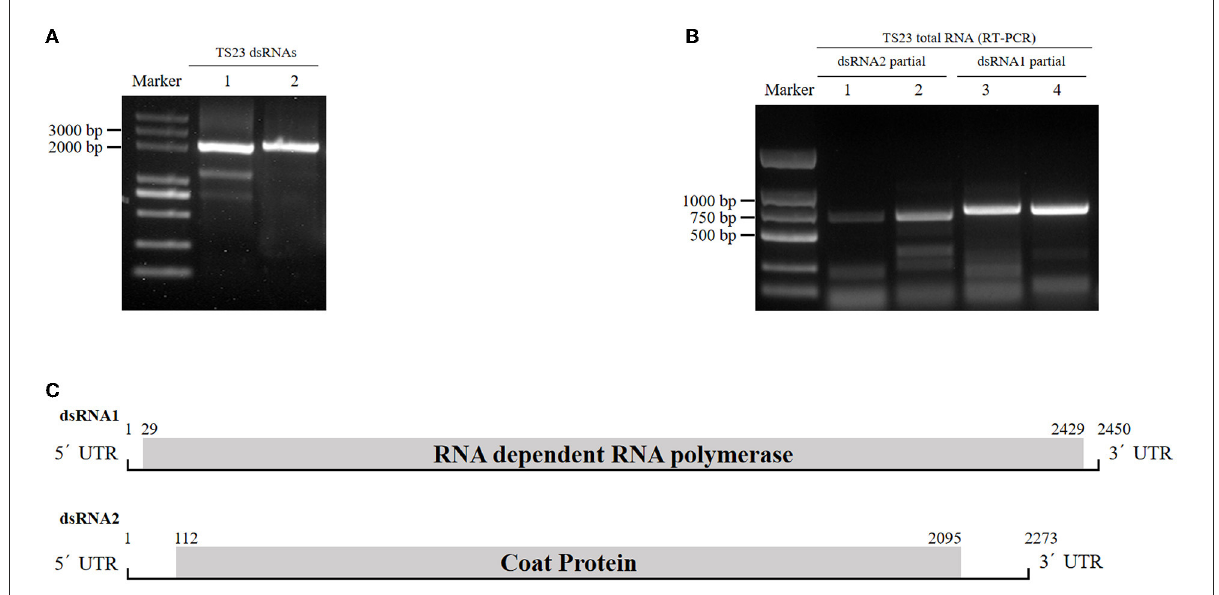
FIGURE1 Identification of RsPV433 in R. solani . (A) Detection of dsRNA in mycelia of R. solani strain TS23. Lane 1 untreated dsRNA extracted from TS23, lane 2 DNase I and S1 nucleoase treated dsRNA extracted from TS23 strain. (B) Detection of RsPV433, using total RNA of TS23 and primers mentioned in the materials and methods section. (C) Schematic representation of the genome organization of RsPV433. RsPV433 contains two dsRNAs, and encode two proteins RdRp and CP, respectively. The ORF encoding RdRp and CP were marked in the figure.